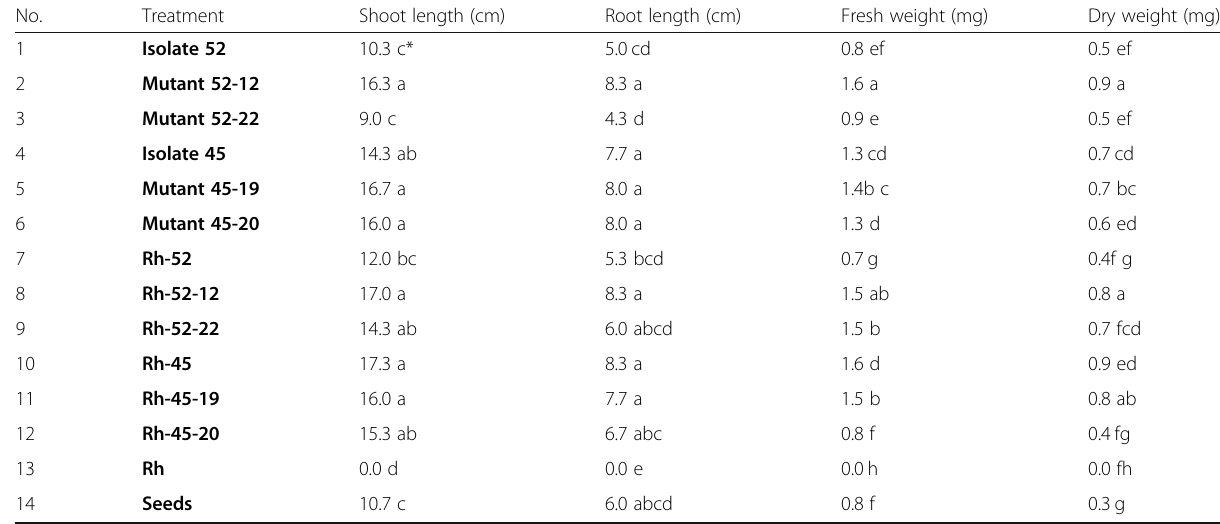
Table 7 Thirty days after inoculation: shoot and root measurements of alfalfa plants under different treatments No.